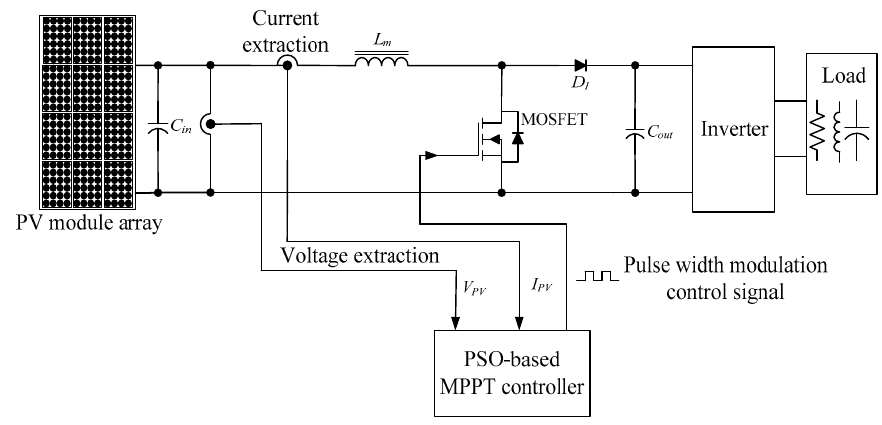
Figure 5. Framework of PSO-based MPPT system.